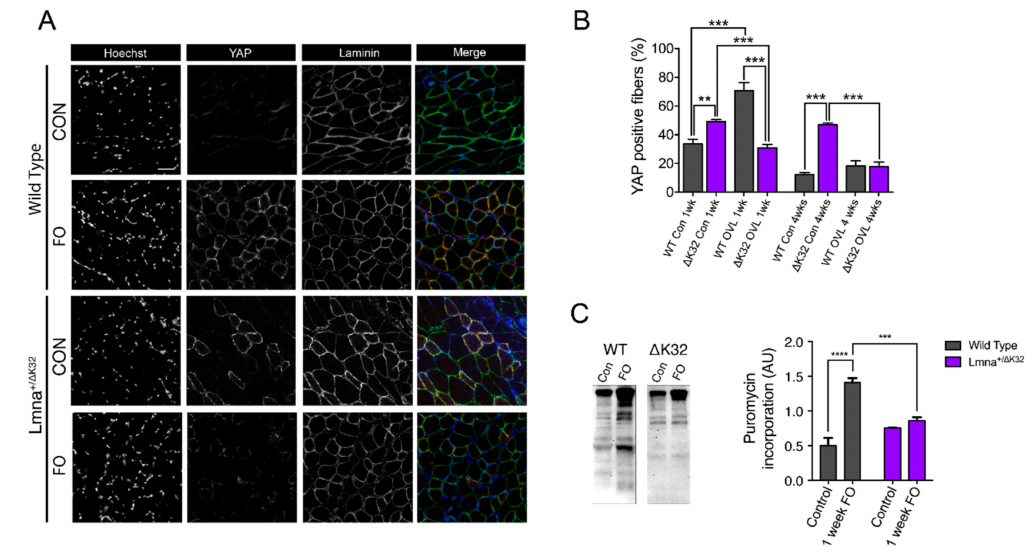
Figure 6. ( A ) Immunofluorescence images of YAP (green) and laminin (red) in control and 7-days FO plantaris muscles from WT and Lmna+/ ∆ K32 mice. Nuclei are stained with Hoechst (blue). Scale bar: 50 µ m. ( B ) Quantification of yes- associated protein (YAP)+ fiber in control and 7 days FO plantaris muscles from WT and Lmna+/ ∆ K32 mice from at least 1000 fibers. ** p < 0.01 versus WT, *** p < 0.001 versus control conditions. ( C ) Representative Western blot and quantification of puromycin incorporation in control and 7 days FO plantaris muscles from WT and Lmna+/ ∆ K32 mice. *** p < 0.001, **** p < 0.0001 versus WT. Values are expressed as means ±